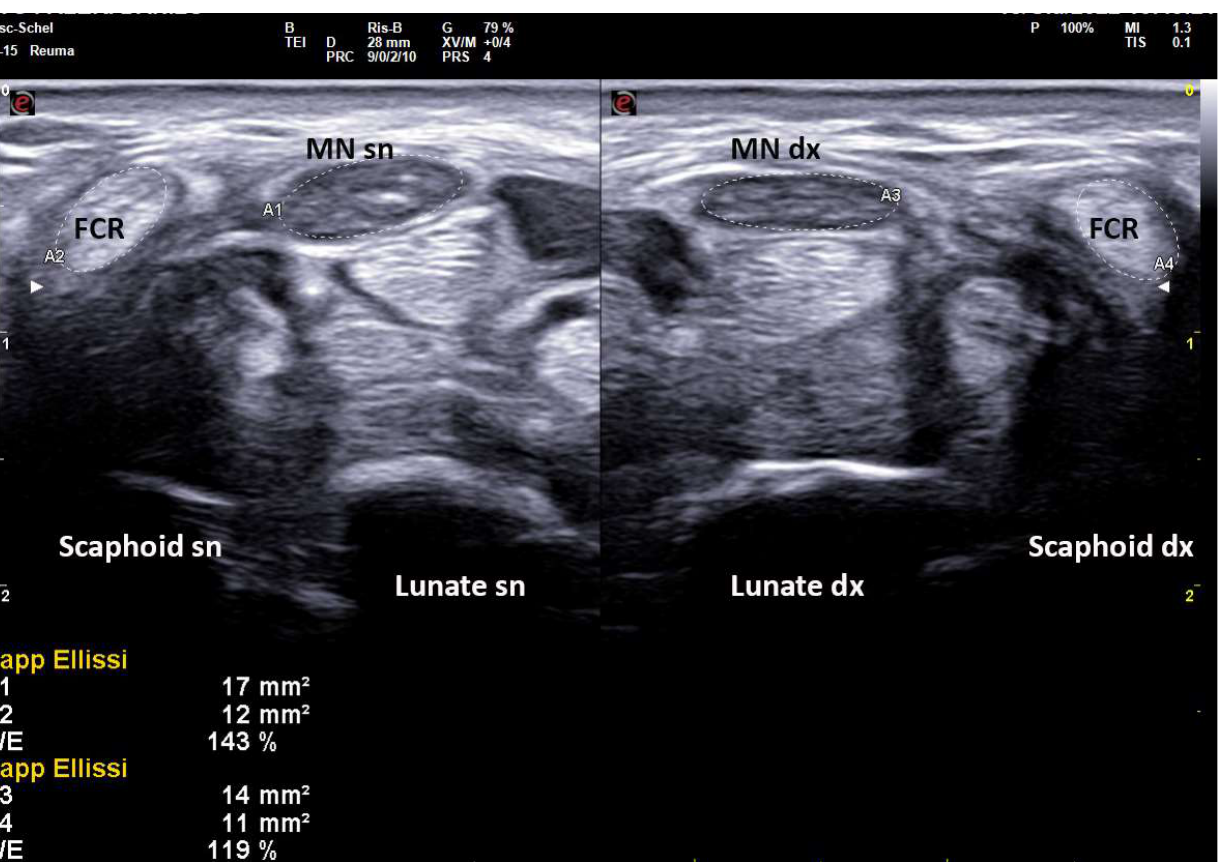
Figure 2. Transverse scan over left and right carpal tunnels in male patient (172 cm × 82 kg, 18.5 cm of wrist circumference) affected with extremely severe CTS (Padua Scale 5 bilaterally). Linear 4–15 MHz probe. Both MN-CSA show frankly pathologic values (Area 1, left: 17 mm 2 , Area 3, right: 14 mm 2 ). NTR is calculated as the ratio between MN-CSA and FCR-CSA (expressed as a percentage), and shows bilaterally pathologic values (left 143%, right 119%) indicative for severe CTS. MN = median nerve, FCR = flexor carpi radialis.